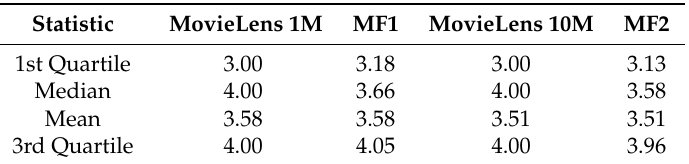
Table 3. Statistics for available ratings and matrix factorization predictions. MF1 and MF2 denote predictions over Movielens 1M and Movielens 10M,